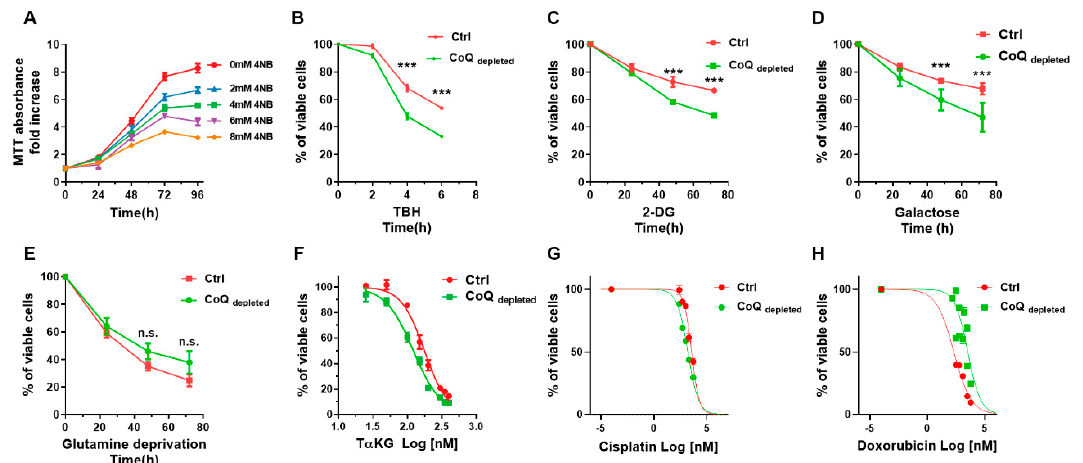
Figure 5. Effect of mitochondrial dysfunction on cell proliferation. ( A ) MCF-7 cell proliferation was assessed by MTT assay in the presence of different concentrations of 4-nitrobenzoic acid up to 96 h. ( B ) MCF-7 cells were cultured in complete DMEM for 96 h in the presence of 4 mM 4-nitrobenzoic acid (CoQ depleted) or vehicle (CTRL), then the cells were exposed to 100 µ M tert-butyl hydroperoxide (TBH) up to 6 h. ( C ) Control and CoQ depleted cells were cultured in complete medium in the presence of 10 mM hexokinase (HK) inhibitor 2-deoxyglucose (2-DG). ( D ) Control and CoQ depleted cells were cultured in glucose free medium supplemented with dialyzed FBS and 5.5 mM galactose. ( E ) Control and CoQ depleted cells were cultured in a glutamine free complete medium. The cell proliferation in panels B-E was monitored by MTT assay for up to 72 h. ( F ) Control and CoQ depleted cells were cultured in complete medium for 24 h in the presence of different concentrations of trifluoromethyl benzyl ‐α‐ ketoglutarate (T α‐ KG). Cell proliferation was assessed by MTT assay. ( G ) Control and CoQ depleted cells were cultured in complete medium for 24 h in the presence of different concentrations of doxorubicin and cisplatin ( H ) for 24 h. Cell proliferation was assessed by MTT assay. Statistical analysis was performed using GraphPad Prism software. Error bars indicate the standard error of the mean (SEM). p values were obtained using unpaired t ‐ test with Welch’s correction. *** p ≤ 0.01.